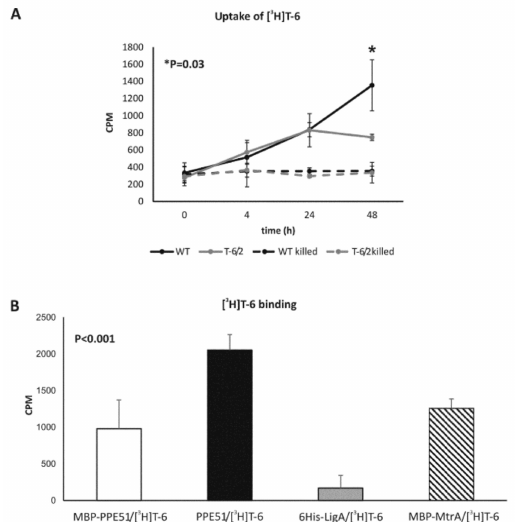
Figure 1. Accumulation of [3H]T-6 in Mtb and its binding to PPE51. ( A ) Accumulation of [3H]T-6 in living (solid line) and thermally killed (dotted line) M. tuberculosis wild-type (WT) and T-6 / 2 mutant cells. Samples were withdrawn and processed at the presented time points. The data were collected from at least three independent experiments, and the results are expressed as the means ± standard errors of the radioactivity counts per minute (CPM). ( B ) Interaction between PPE51 and tritiated T-6 (PPE51 / [ 3 H]T-6) expressed as the emission (CPM) of T-6 bound to the protein. As a control